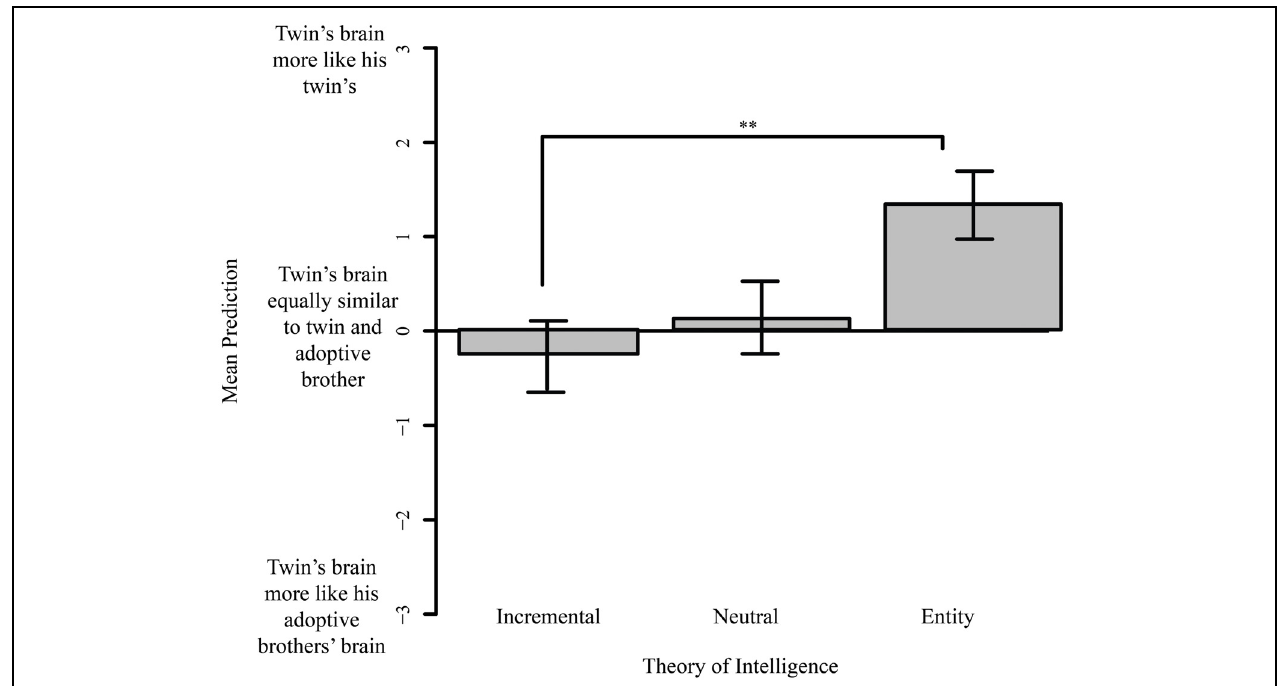
FIGURE 4 | Biological versus adoptive brothers. Mean difference in predictions about similarity of biological twins’ versus adoptive brother’s adult brains, with participants grouped by theory of intelligence. Error bars indicate SE. ∗∗ p <